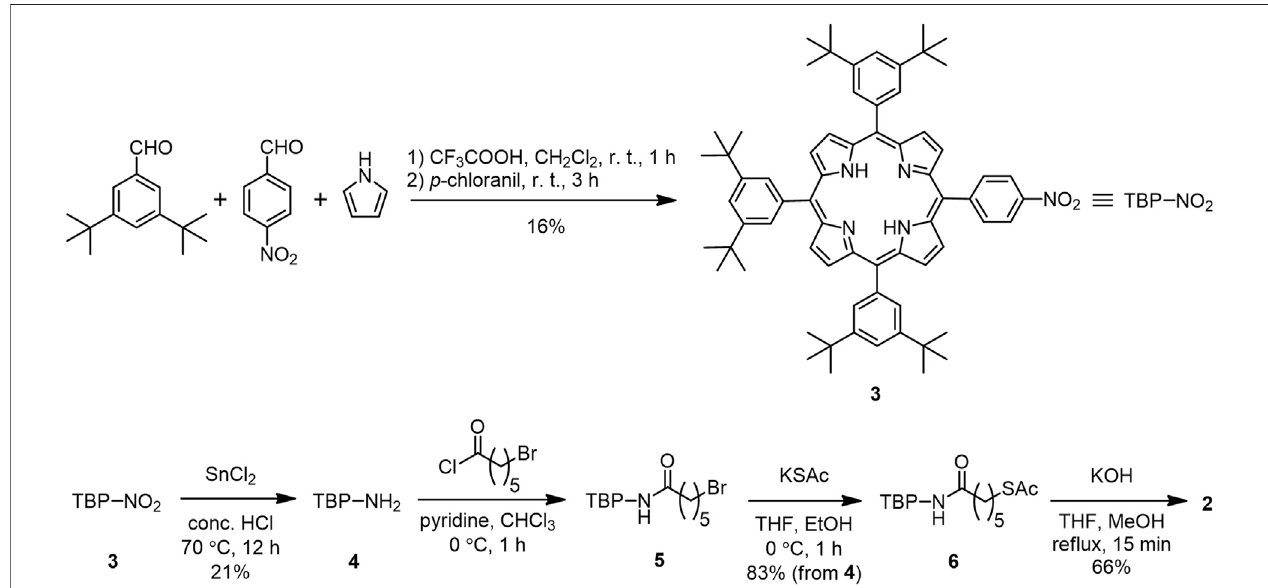
SCHEME 2 | Synthetic route to porphyrin – alkanethiol 2 with bulky tert -butyl substituents.